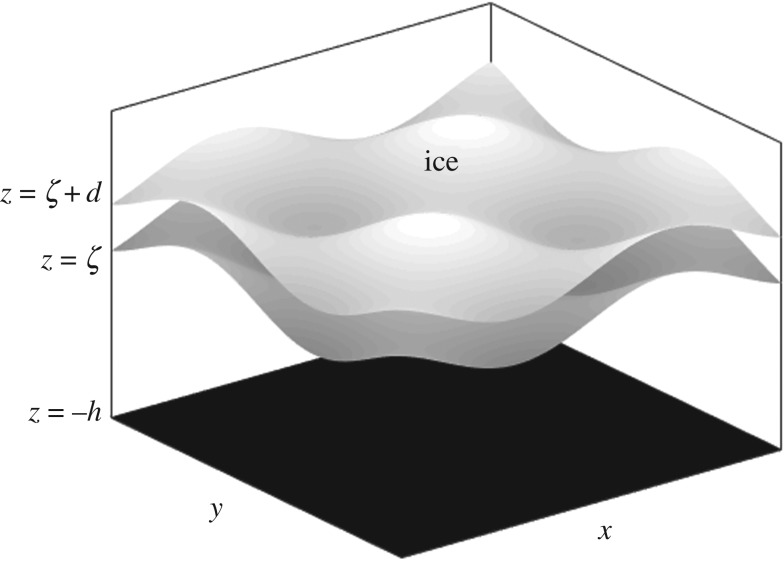
A schematic representing the domain for (2.1).